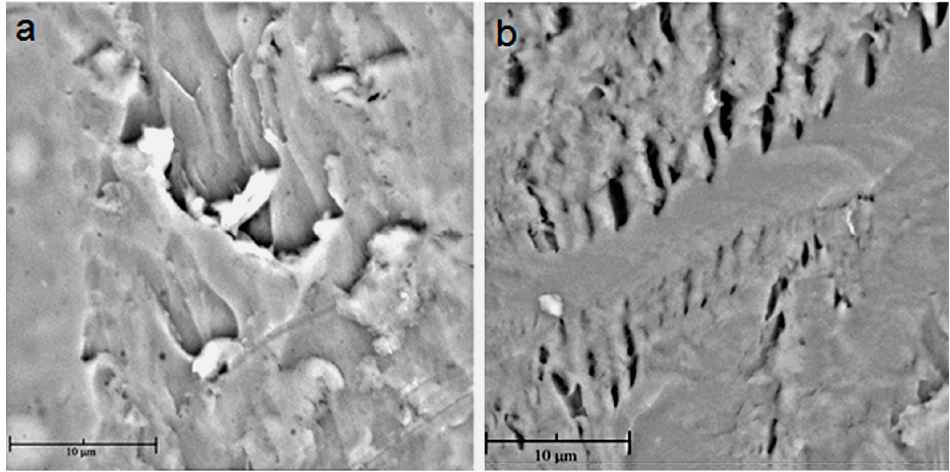
Figure 3. SEM images of imprinted ( a ) and non-imprinted ( b ) membranes at 8000× magnification.